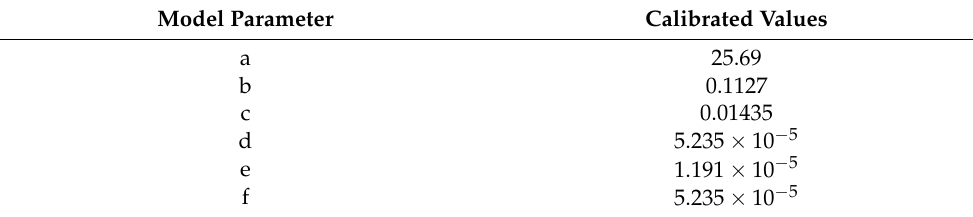
Table 8. Constants of ID